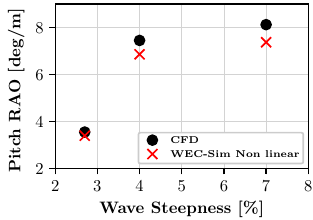
Fig. 12. The pitch-RAOs for high- and midfidelity are compared in conjunction with the wave steepness. For a wave with lower steepness, the buoy pitch motion becomes more pronounced, and the deviation between the two solutions is larger.